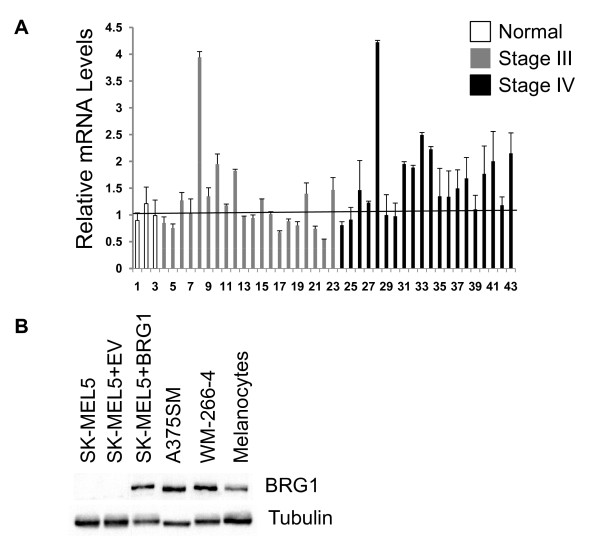
BRG1 is highly expressed in patient derived melanomas and metastatic melanoma cell lines. A. Tissue Scan Melanoma qPCR Arrays (Origene) containing cDNAs from patient derived normal skin, stage III melanomas, and stage IV melanomas were subjected to qRT-PCR with BRG1 specific primers. BRG1 levels were normalized to β-actin. The results were averaged from values obtained by performing three PCR arrays. B. Western blot comparing BRG1 levels in two invasive melanoma cell lines (A375SM and WM-266-4) and human epidermal melanocytes with that in BRG1 deficient SK-MEL5 cells, SK-MEL5 cells reconstituted with empty vector (EV), and BRG1 reconstituted SK-MEL5 cells. Total cell lysate was loaded. Tubulin is a loading control.